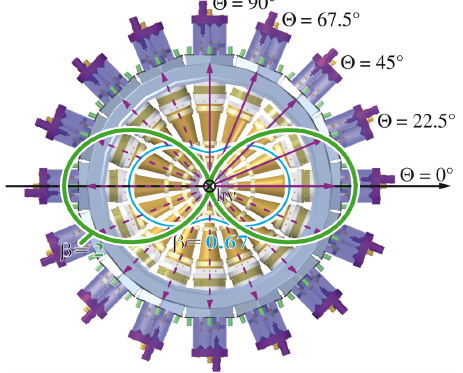
FIG. 6. Geometry of the 16-fold electron TOF spectrometer setup. The FEL beam enters perpendicular into the plane of the figure. The angular distribution for Ne 2p (blue) and He 1 s (green) photoelectrons is depicted for a wavelength of 26 nm and horizontally polarized light.